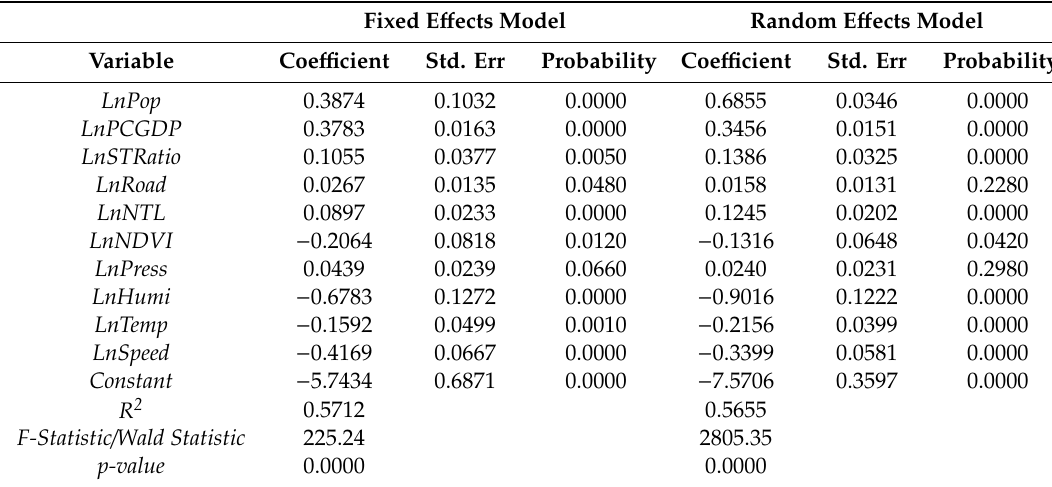
Table 4. Results of the fixed e ff ects and random e ff ects